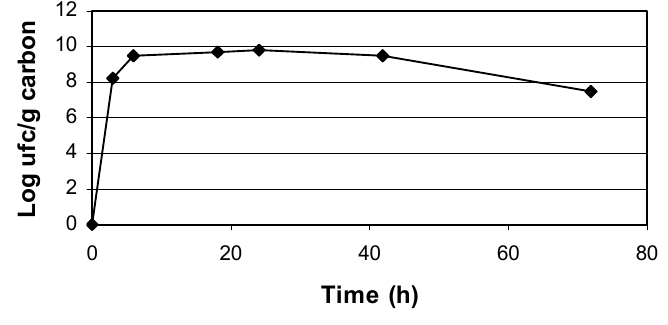
FIGURE 2. Growth of S. Marcescens attached on activated carbon.